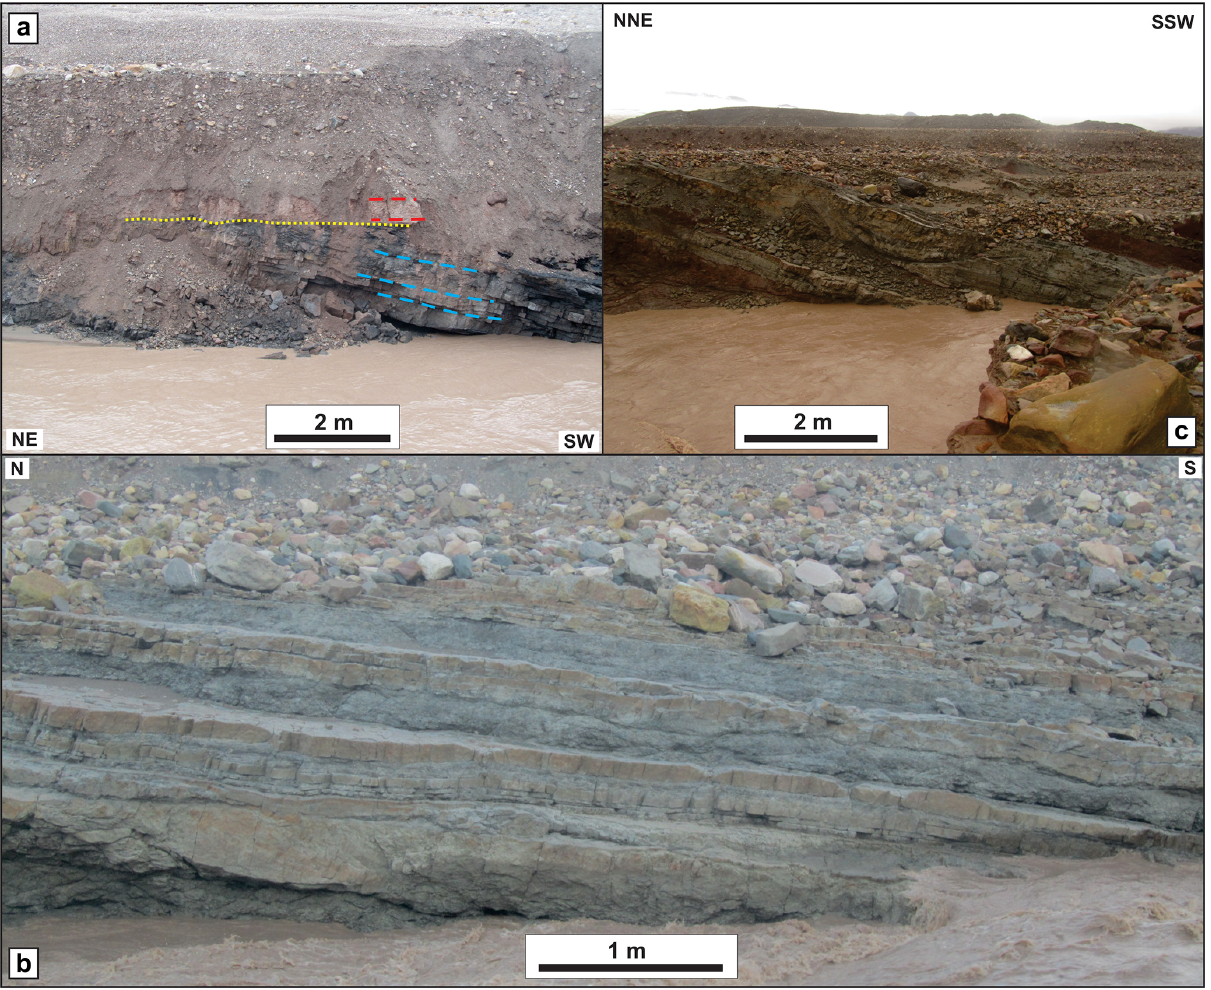
Figure 7. (a) Outcrop photographs showing southwestwardly tilted sandstone- and coaly-shale-rich beds of the Billefjorden Group (dashed blue) unconformably (unconformity in dotted yellow) overlain by flat-lying (dashed red) red beds of the Hultberget Formation. Outcrop located at the northern end of the riverbed (see Fig. 4). (b) Grey sandstone and shales interbedded with thin beds of yellow sandstones (transitional between Billefjorden Group and Hultberget Formation?). Outcrop location in Fig. 4. (c) Red shale interbedded with grey and yellow sandstone characteristic of the Hultberget Formation in Odellfjellet, Austfjorden. See Fig. 4 for outcrop